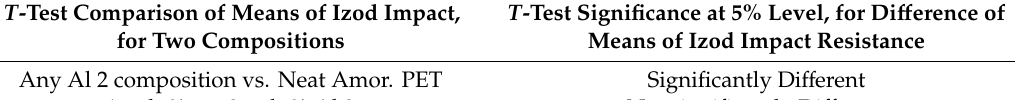
Table 11. Unpaired t -test for Al 2—PET compositions to determine in the means of Izod impact values are di ff erent at the 5% significance level. The same null and alternative hypotheses were used as in Table 8. vs. is